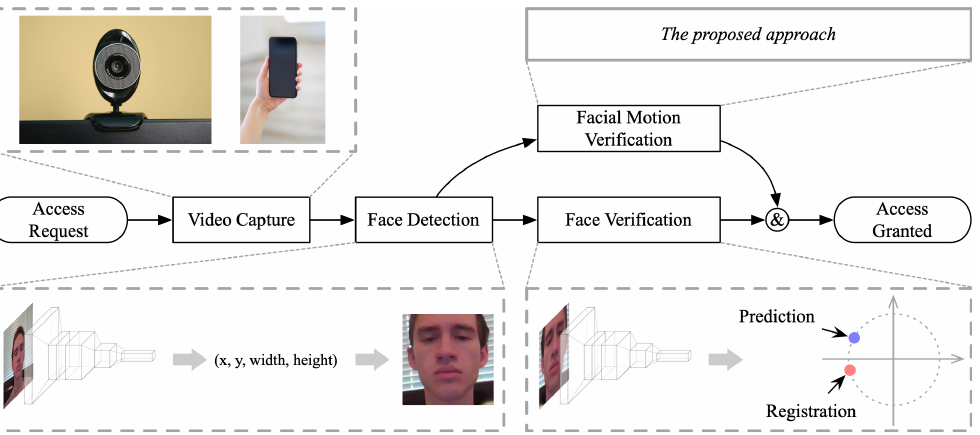
Figure 1. Facial motion augmented identity verification system. The shown face is one of the subjects in our dataset introduced in Section